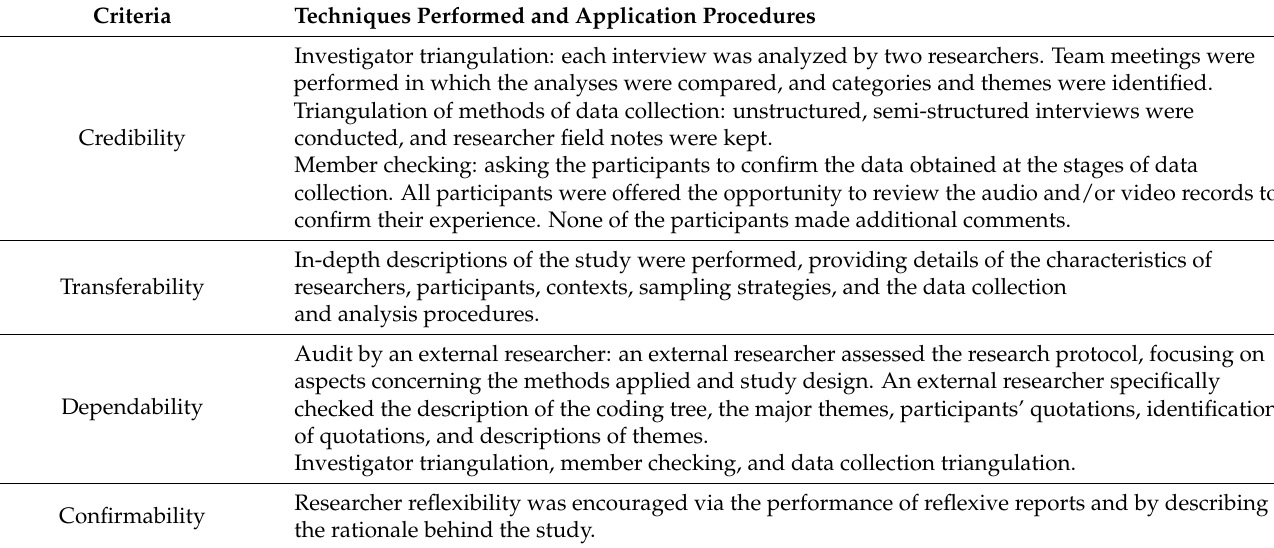
Table 2. Trustworthiness